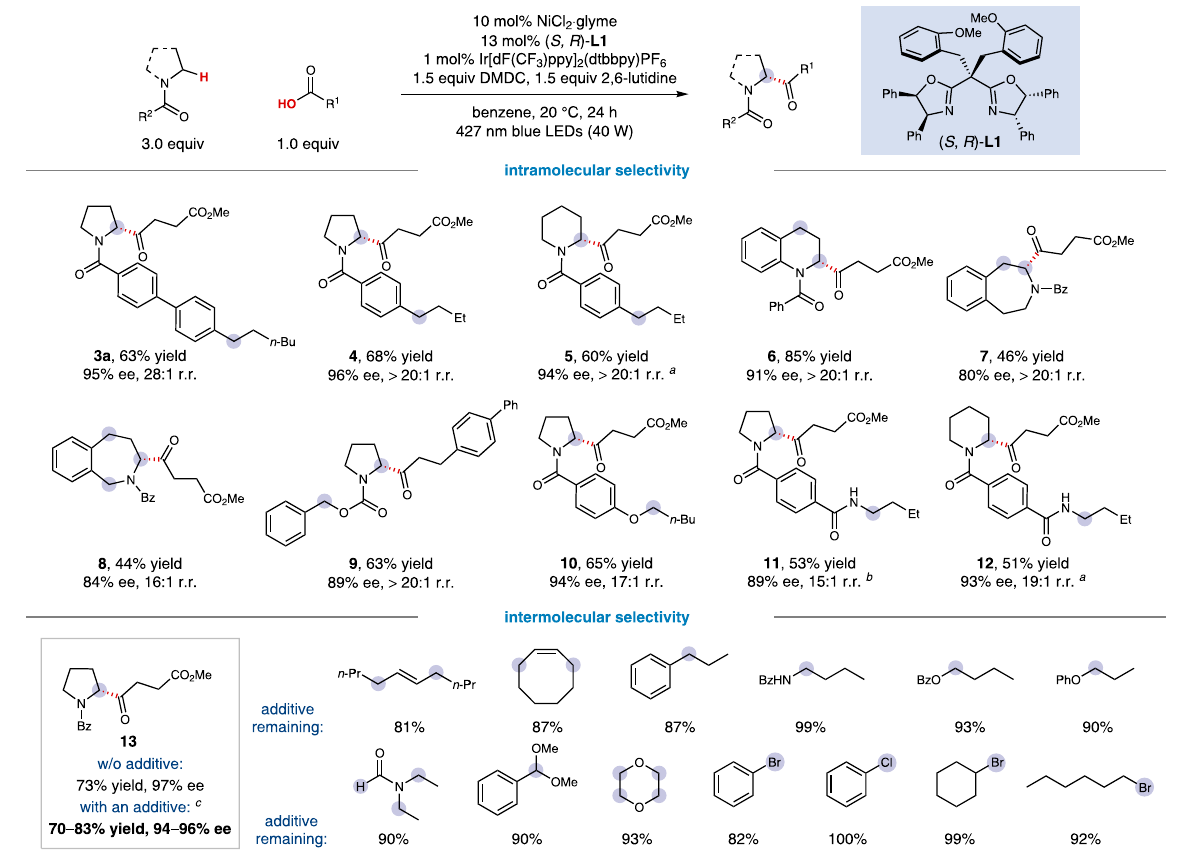
Fig. 2 | Generality of intramolecular and intermolecular site- and chemos- electivity. All data represent the averageoftwo experiments, and all yields for the catalyticproductsareofisolatedproducts.Unlessotherwisestated,reactionswere